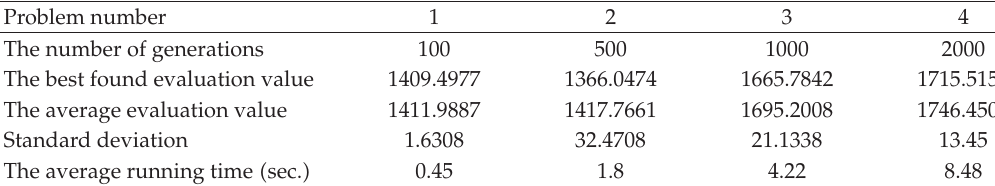
Table 5: Computational results statistics.